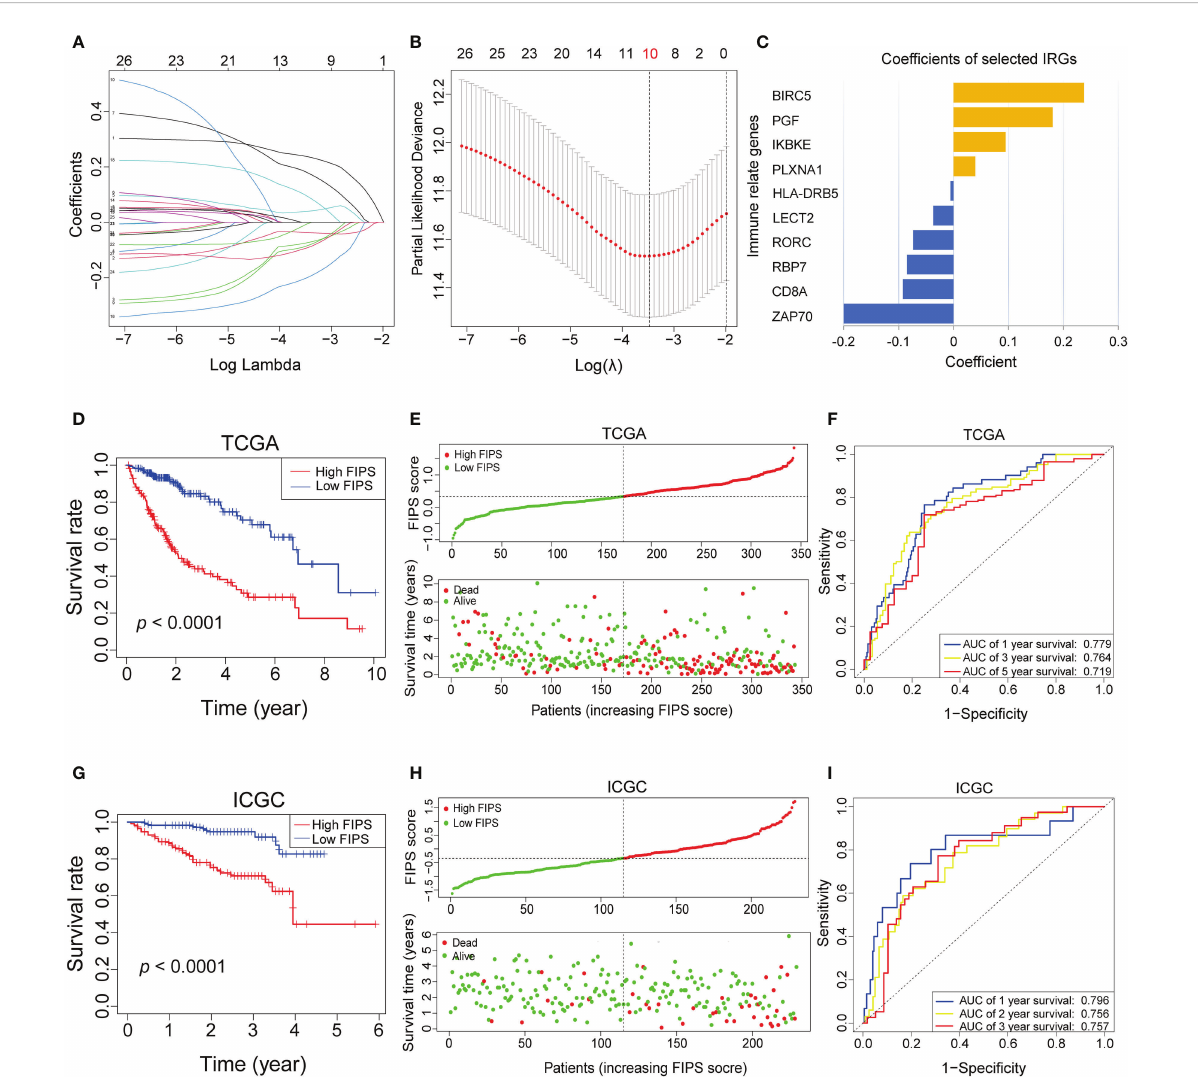
FIGURE 2 (A – C) Least absolute1 shrinkage and selection operator (LASSO) regression was performed, calculating the crucial genes (A, B) and coef fi cients (C) . (D) Kaplan – Meier curves showed that the high-FIPS subgroup had worse overall survival than the low-FIPH subgroup in The Cancer Genome Atlas (TCGA) cohort. (E) Distributions of FIPS scores and survival status of HCC patients in the TCGA cohort. (F) Receiver operating characteristic (ROC) curves of FIPS for predicting the 1/3/5-year survival in the TCGA cohort. (G) Kaplan – Meier curves showing that the high- FIPS subgroup had worse overall survival than the low-FIPS subgroup in the International Cancer Genome Consortium (ICGC) cohort. (H) Distributions of FIPS scores and survival status of HCC patients in the ICGC cohort. (I) ROC curves of FIPS for predicting 1/2/3-year